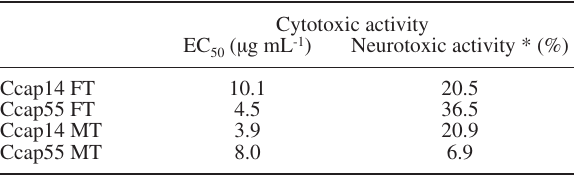
Fig . 3. – Haemolytic activity of Cyanea capillata venoms obtained from fishing tentacles (FT) and mesenteric tentacles (MT). Ccap14, pooled sample of 9 medusae with an average umbrella diameter of 14.2 cm; Ccap55, one medusa with an umbrella diameter of 55 cm, mean ± SD; number of replicate analysis >16. Table 2. – Cytotoxicity towards RTgill W1 cells and neurotoxicity Fig . 4. – Dose-dependent cytotoxic activity. RTgill W1 cell viability measured by a mouse neuroblastoma cell assay; venom preparations after 48 h incubation with venoms of Cyanea capillata (Ccap14, from nematocyst suspensions, Ccap14: 9 medusae with an average pooled sample of 9 medusae with an average umbrella diameter of umbrella diameter of 14.2 cm; Ccap55: one medusa of Cyanea cap- 14.2 cm; Ccap55, one medusa with an umbrella diameter of 55 cm) illata with an umbrella diameter of 55 cm; FT, fishing tentacle; MT, obtained from fishing tentacles (FT) and mesenteric tentacles (MT); mesenteric tentacle/oral arm mean ± SD; number of replicate analysis